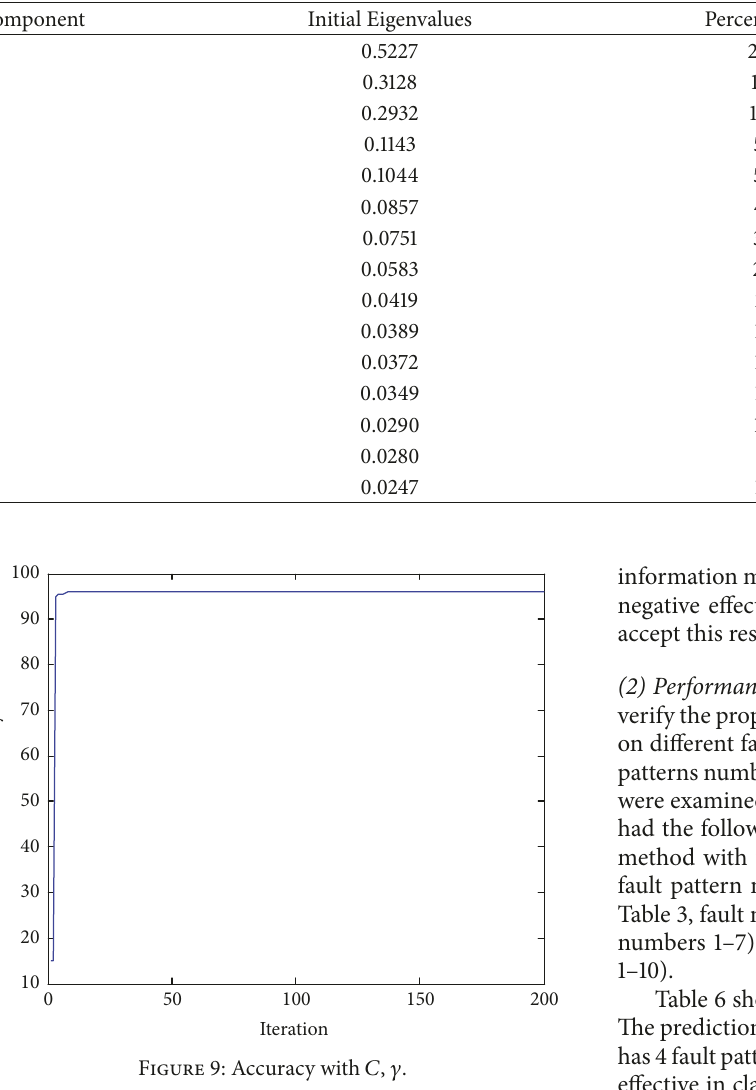
Table 4: Principal component analysis.